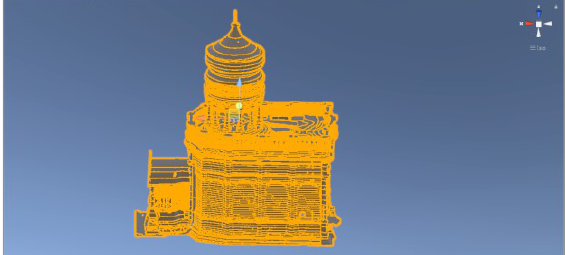
Figure 2. The arbitrary separation of the model into “peel” shaped smaller